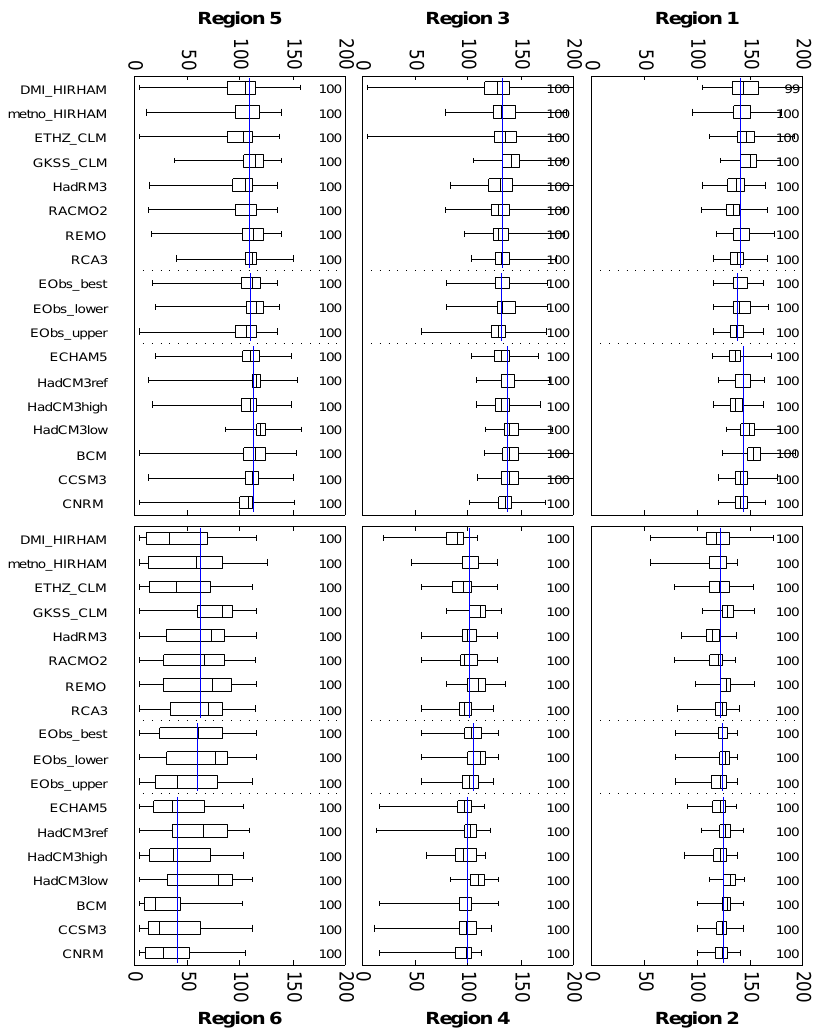
Fig. 3. Day number for onset of the vegetation period (variable a in Eq. 1) simulated with the SBI model, driven by three different temperature datasets: (i) Eight RCM ERA40 ensemble members (left part) for the reference period 1961–1990. (ii) E-Obs best estimate and the lower and upper 95% confidence limits (middle part) for the reference period 1961–1990. (iii) Seven RCA3 GCM ensemble members (right) for the reference period 1961–1990. Data was analysed for the six regions, defined in Fig. 1. Each box (rectangle) extends from the lower to the upper quartile with the median indicated by the line in between. The whiskers extend to the minimum/maximum values. The horizontal lines across the boxes represent the average of the medians of the individual members of the three ensembles. The percentage (rounded to the nearest integer value) of years when the weather allows for an onset of the vegetation period is indicated above the boxes.”